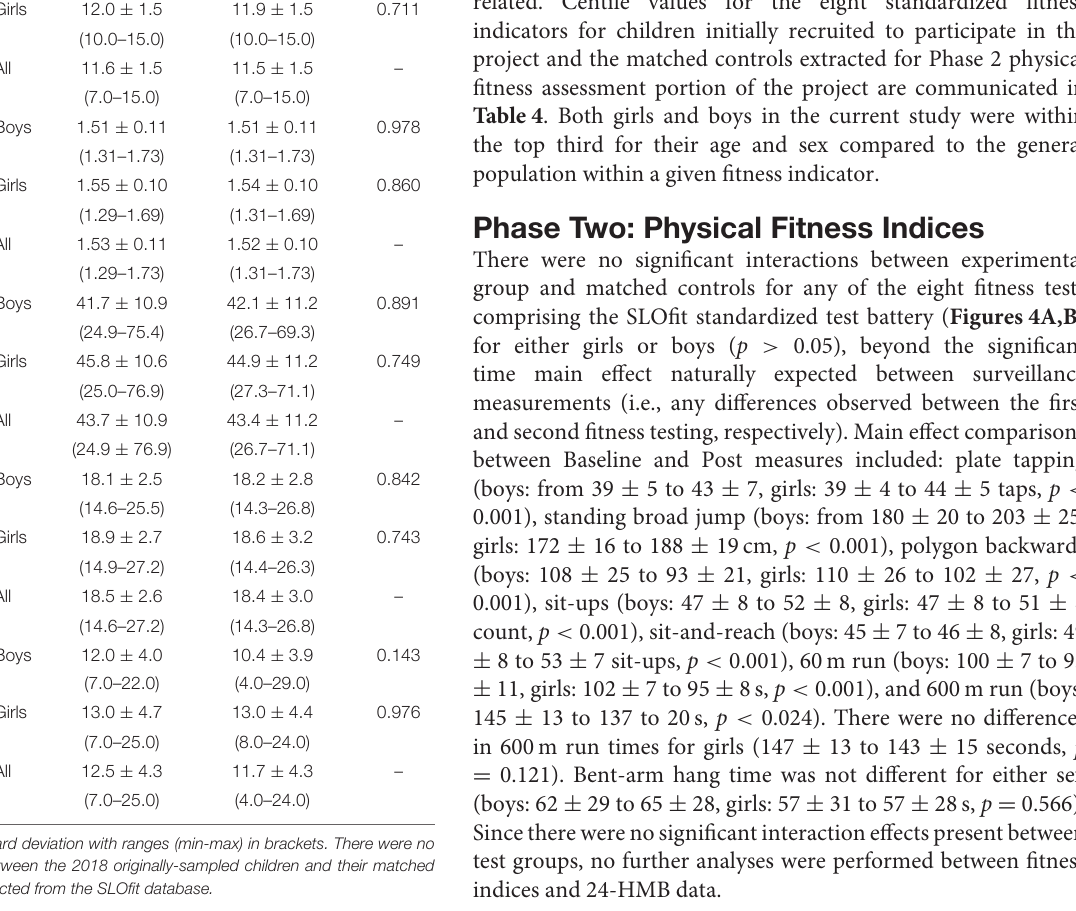
Since there were no significant interaction effects present between test groups, no further analyses were performed between fitness indices and 24-HMB